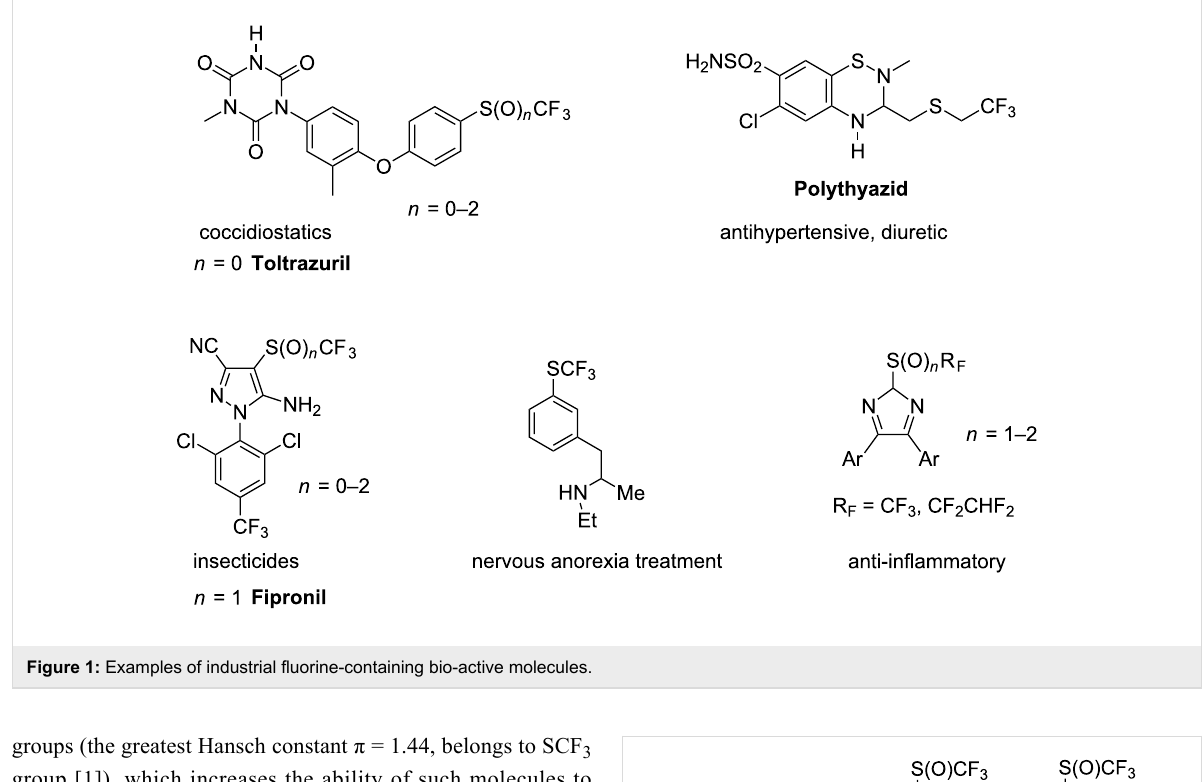
groups (the greatest Hansch constant π = 1.44, belongs to SCF 3